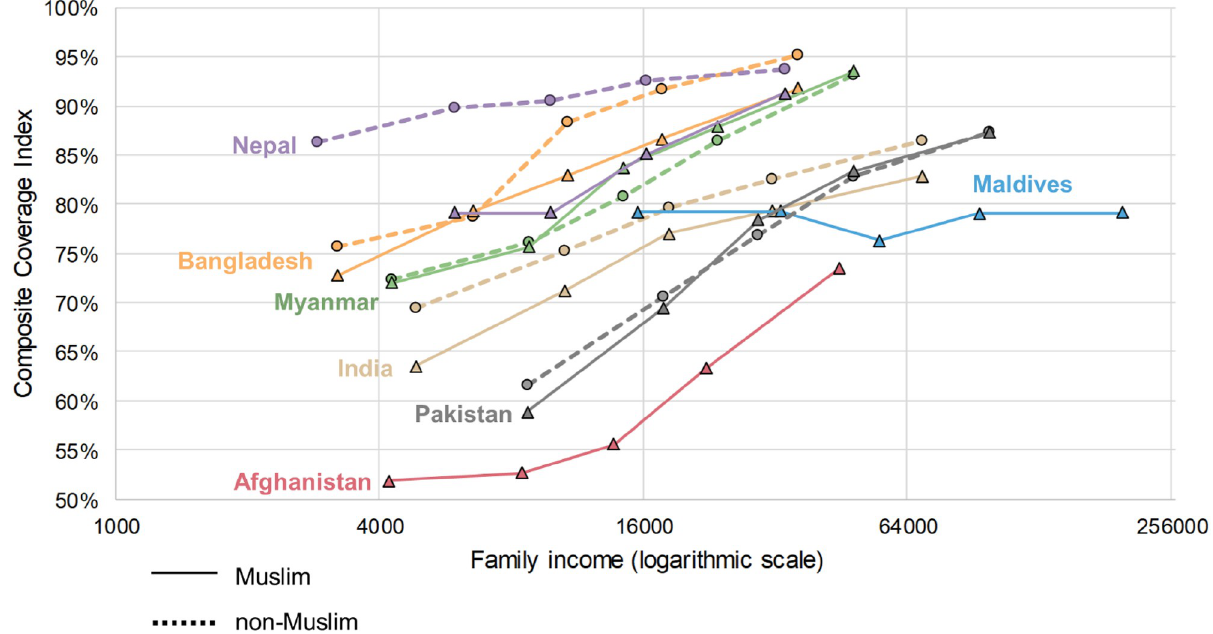
Fig 2. Relationship of religion and composite coverage index in 7 South Asian countries. Made with Natural Earth naturalearthdata.com.